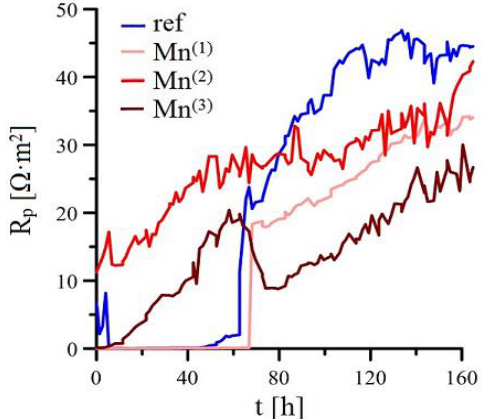
Figure 5. Time dependency of R P for 4 parallel samples in simulated concrete pore solutions.